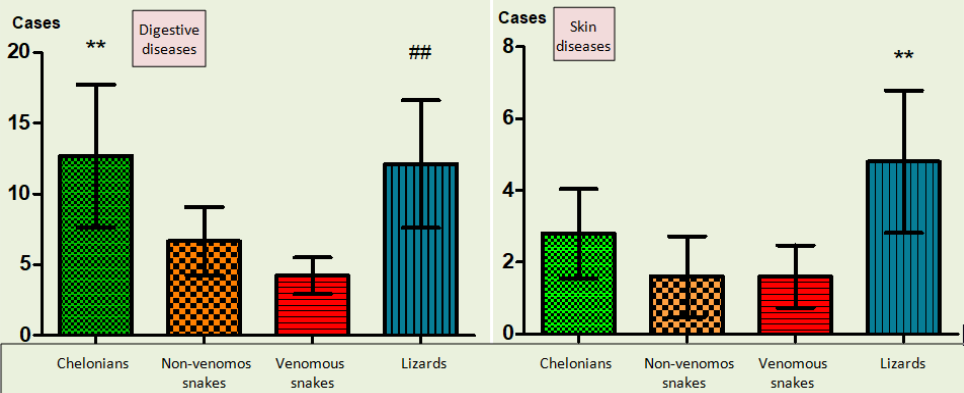
Figure 3. The incidence of digestive diseases (the most common—left image) and skin diseases (the second most common—right image); comparison of chelonians vs. snakes (where ** means p <0.01); lizards/snakes ( where ## means p < 0.01) and lizards vs. chelonians and snakes ( where ** means p < 0.01.).